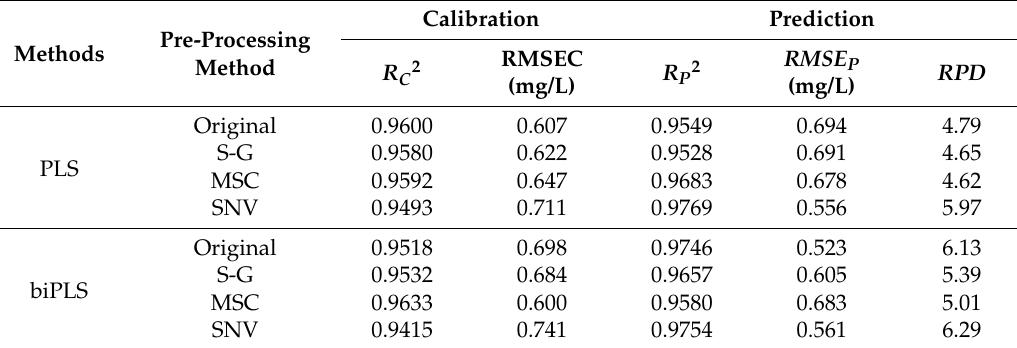
Table 4. The results of pre-processing methods for calibration and prediction model.